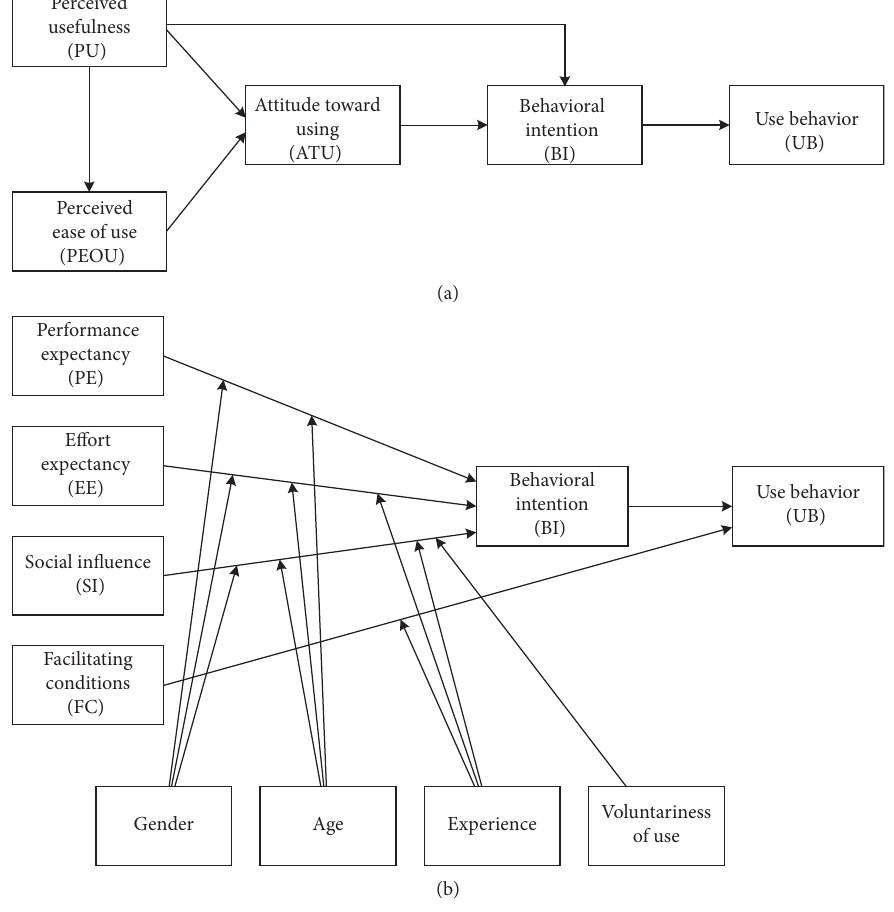
Figure 1: (a) Original TAM proposed in Davis [17]. (b) Original UTAUT proposed in Venkatesh et al.